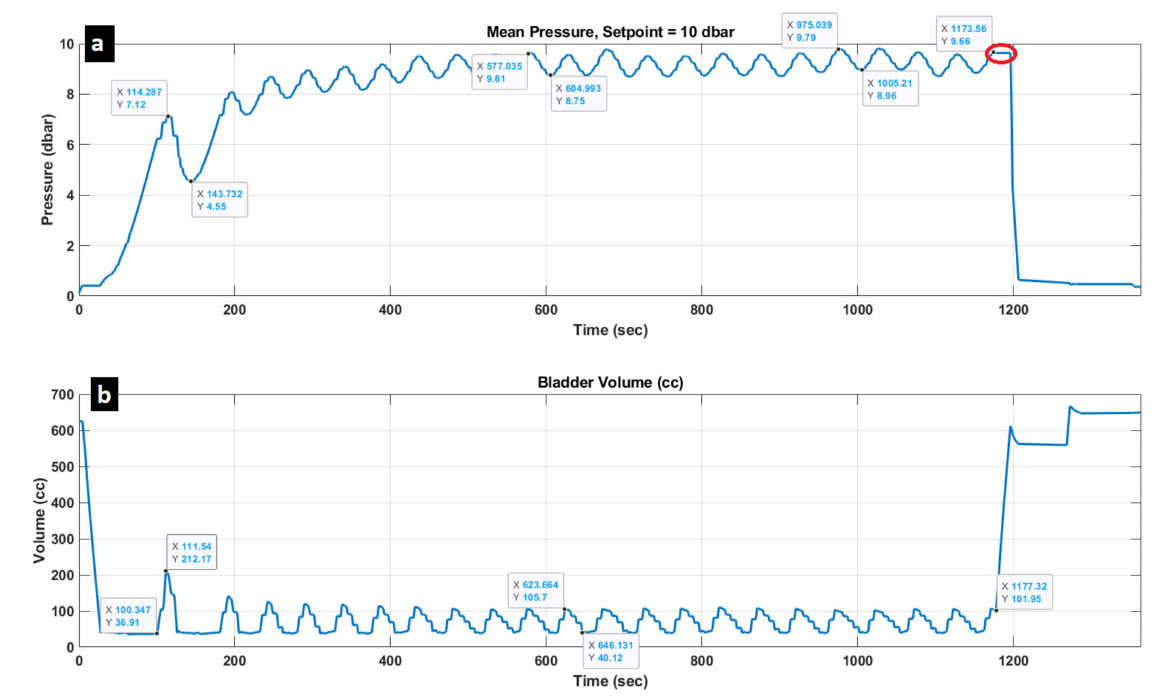
Figure 19. Sea trial deployment #1: ( a ) hydrostatic pressure reading; ( b ) bladder volume.